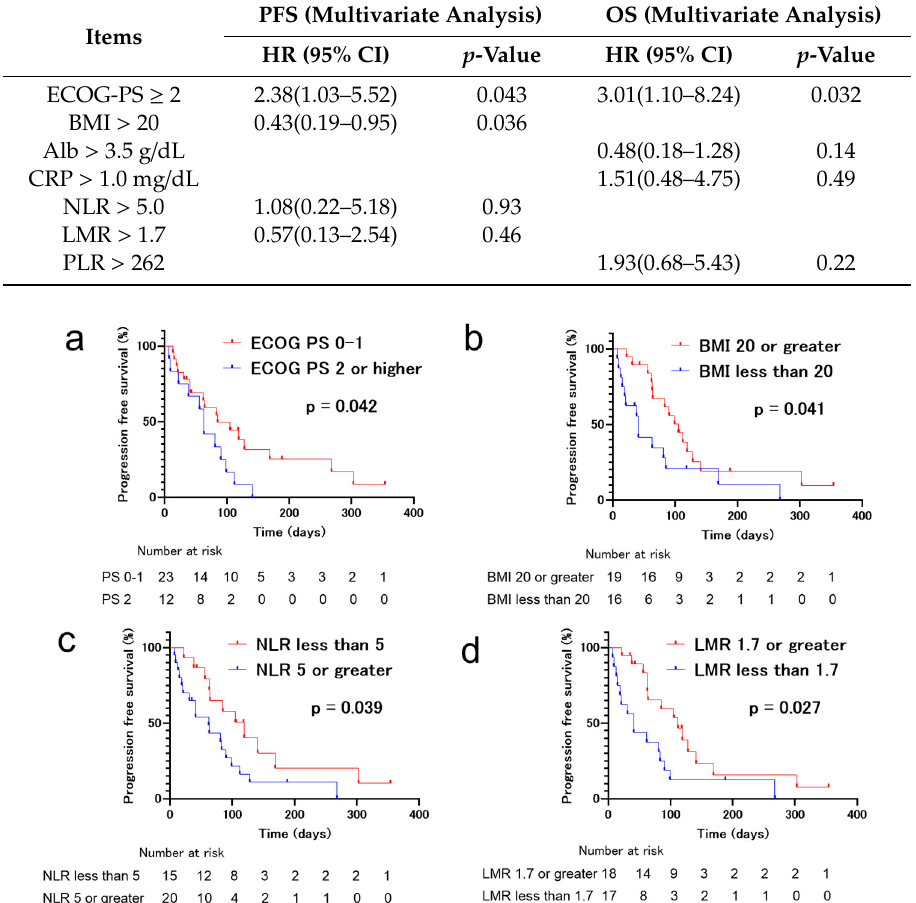
Figure 3. Kaplan–Meier survival curves for progression-free survival (PFS) of patients who received immune checkpoint inhibitor (ICI) rechallenge treatment. ( a ) Eastern Cooperative Oncology Group (ECOG-PS) ≥ 2, ( b ) body mass index (BMI) ≤ 20, ( c ) neutrophil-to-lymphocyte ratio (NLR) > 5, and ( d ) lymphocyte-to-monocyte ratio (LMR) ≤ 1.7 were significantly associated with inferior PFS.